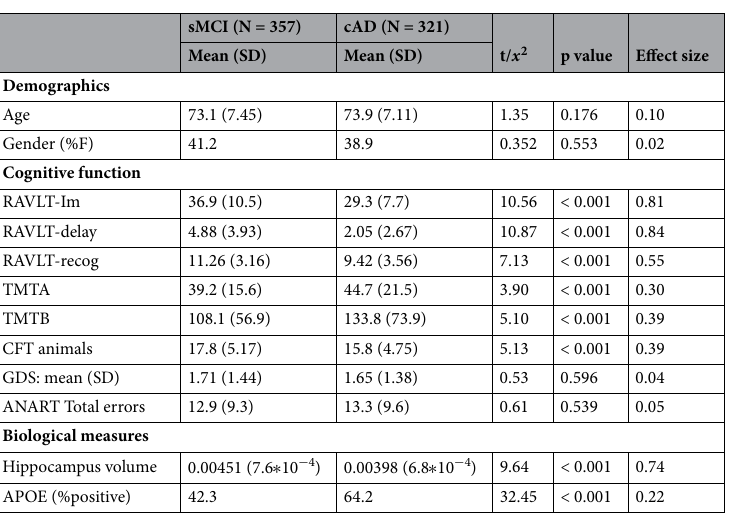
Table 1. Demographics, cognitive function and biological measures in patients defined as stable MCI and converters to AD. sMCI stable Mild Cognitive Impairment, cAD converted to Alzheimer’s disease, RAVLT Rey